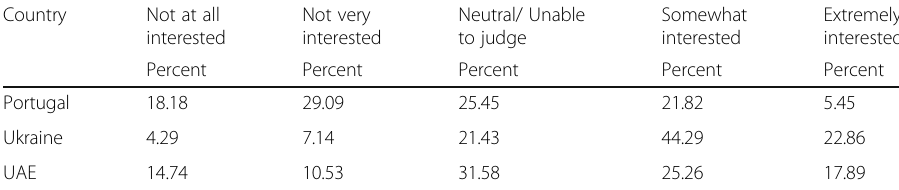
Table 9 Interest in enrolling in a distance education course